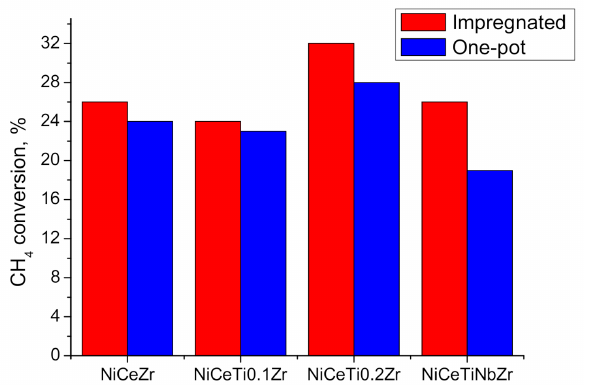
Figure 12. The dependences of CH 4 conversion on Ni introduction method at 650 ◦ C. Feed 15% CH 4 + 15% CO 2 + N 2 balance, contact time 10